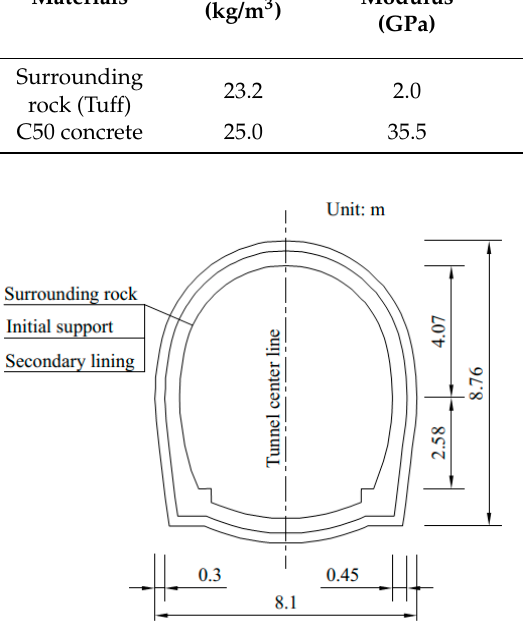
Figure 7. Tunnel dimensions. Table 7. The physical and mechanical parameters of surrounding rock and concrete.